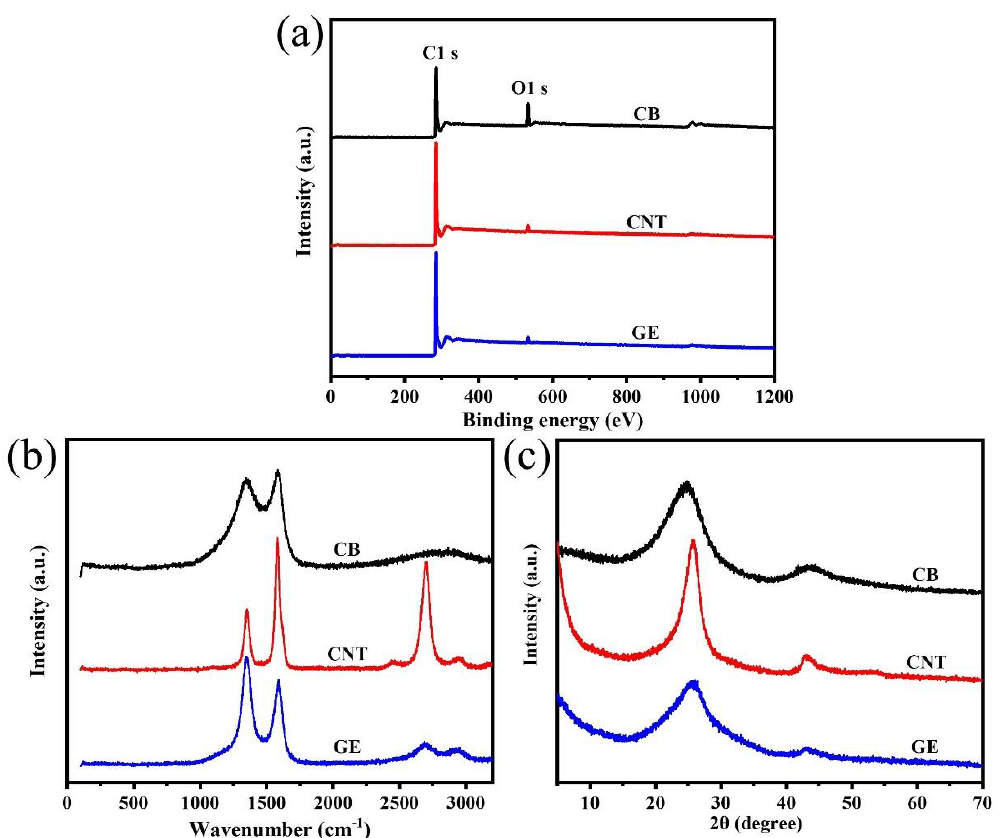
Figure 2. ( a ) XPS survey spectra; ( b ) Raman spectra, and ( c ) XRD patterns of CB, CNTs, and GE.